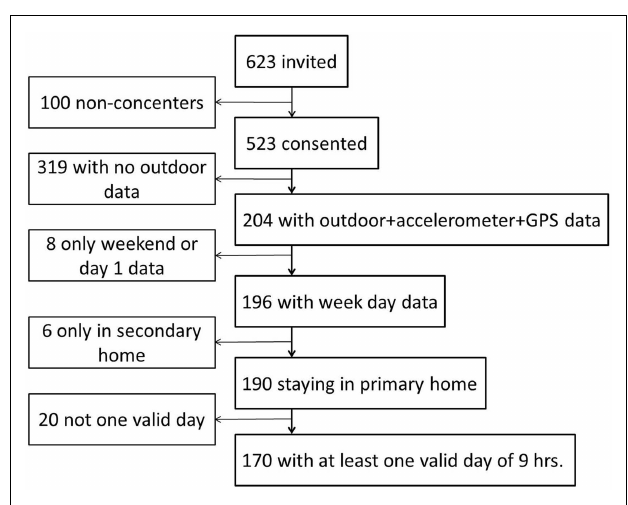
FIGURE 1 | Reduction of the study population